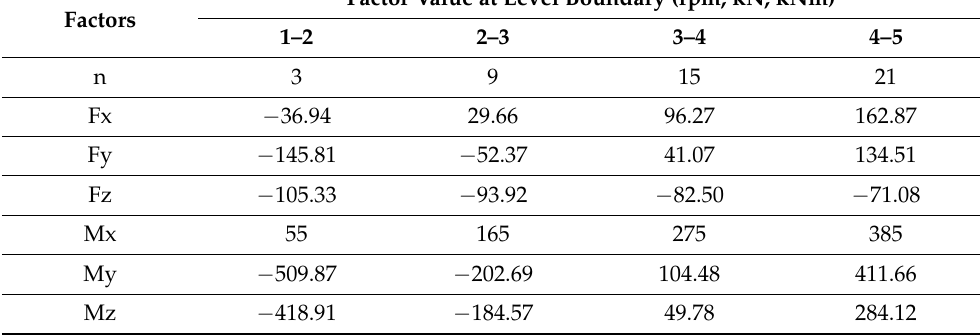
Table 6. Factor Level